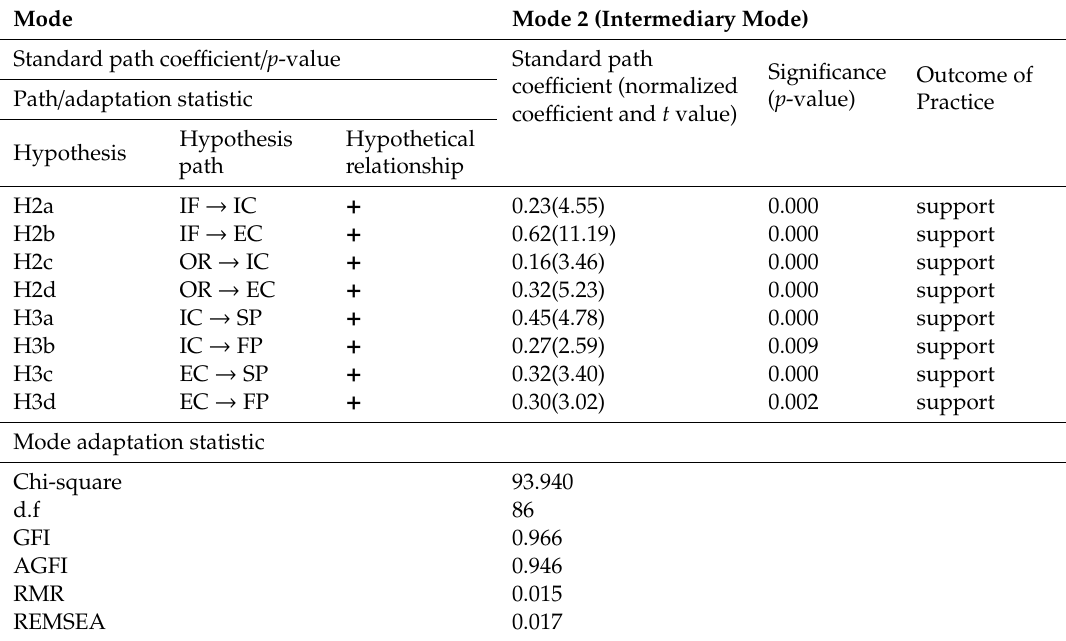
Table 2. Mediation e ff ect analysis